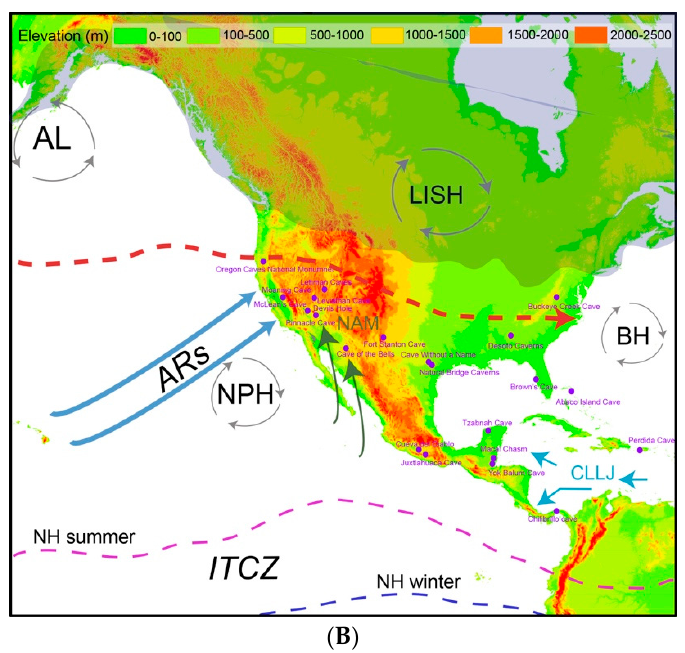
Figure 2. Conceptual model of components of the climate system for modern ( A ) and last glacial maximum ( B ) conditions in North and Central America. Climate models and paleoclimate records indicate that the LGM was characterized by a stronger Aleutian low (AL), weaker North Pacific high (NPH) [49]; high pressure over the Laurentide ice sheet (LISH) and a tilted westerly storm track (red dashed line) [4]; more frequent atmospheric river storms along the west coast of North America (ARs) [49]; a weaker North American monsoon (NAM) [50]; weaker Bermuda high (BH) [51] and Caribbean low level jet [52]; and small southward (<1 ◦ ) shifts in ITCZ position [53].